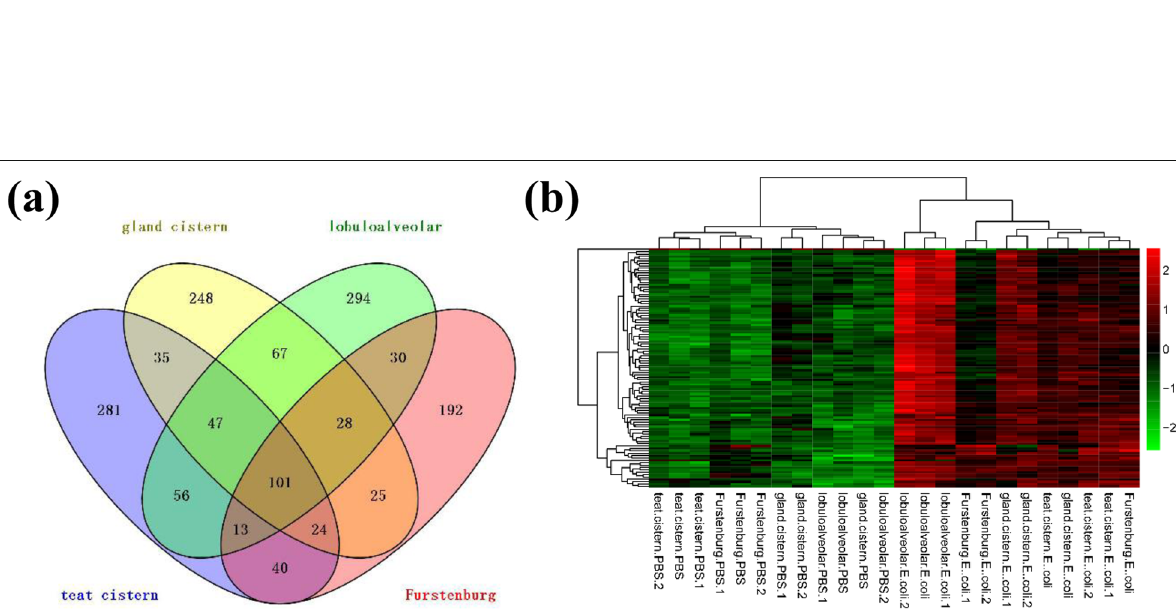
Fig. 2 a Venn diagram of DEGs in the four different regions. b Hierarchical clustering of 101 overlapping differentially expressed genes